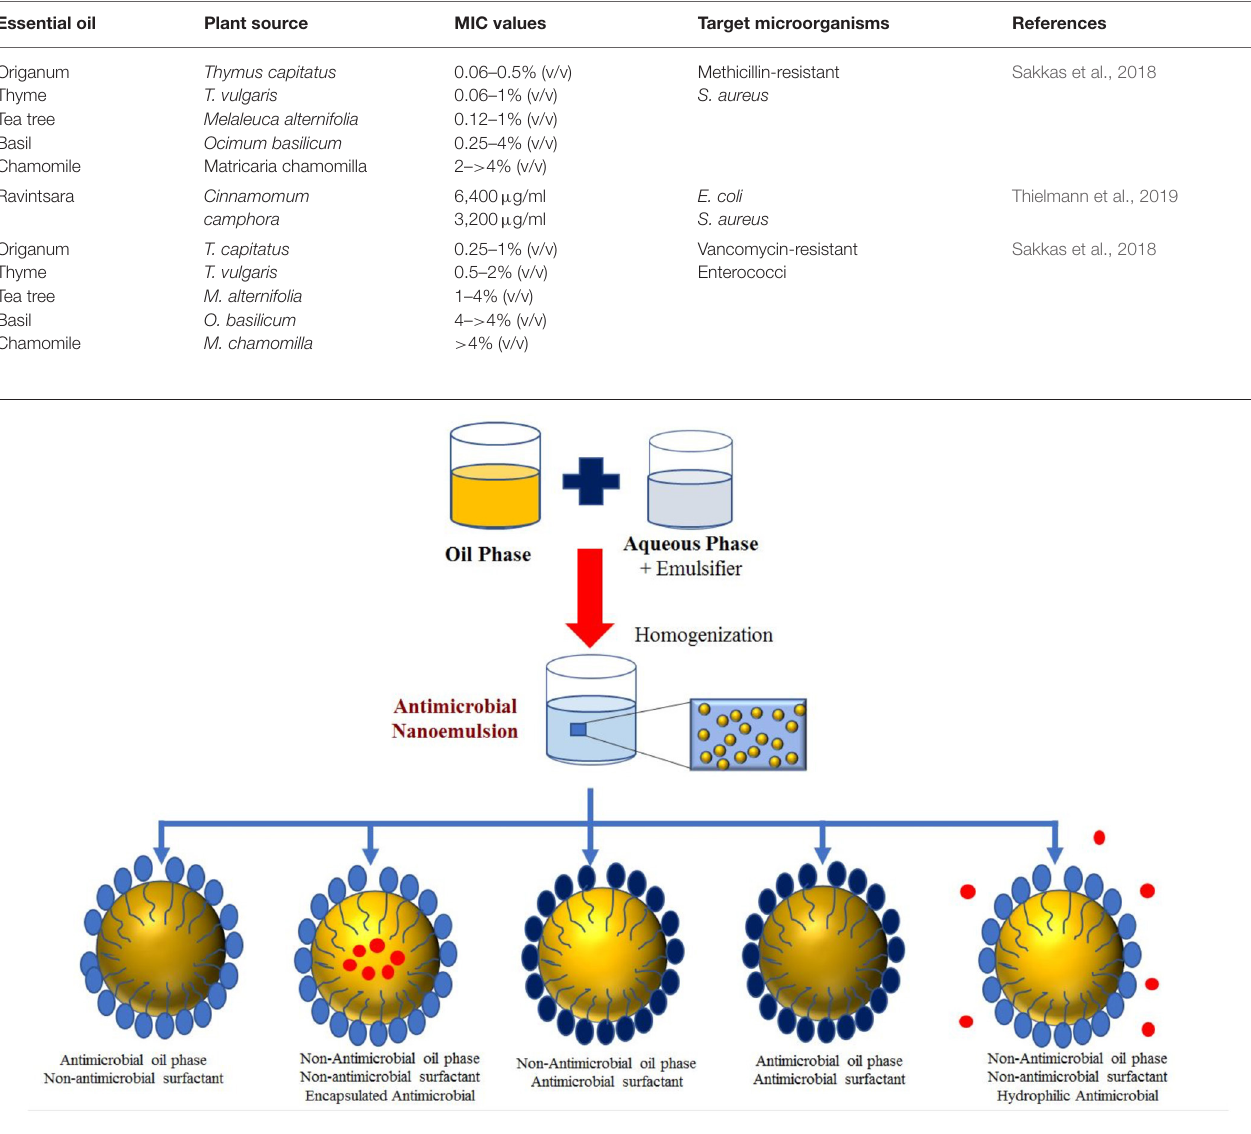
FIGURE 3 | Classification of antimicrobial nanoemulsions based on the location of the antimicrobial